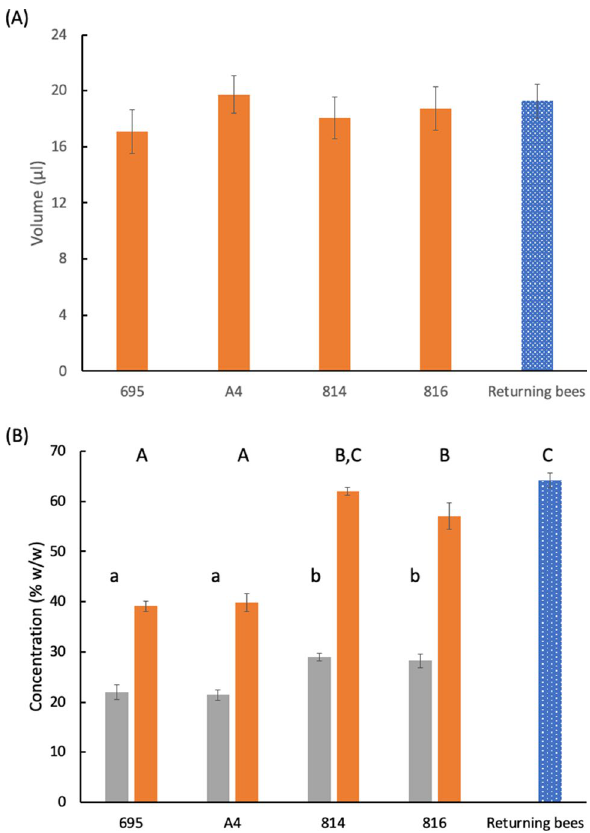
Figure 1. Crop contents of honey bees foraging on four cultivars of Macadamia integrifolia and captured on return to the hive. Nectar concentrations of the four cultivars are included. Values are means ± 95% CI (n = 30). ( A ) Volume in µl. ( B ) Concentration in % w/w of crop contents (orange) and nectar of the same cultivar (grey). Different letters indicate significant differences in crop contents; small letters refer to differences in nectar concentrations. Significant differences were determined by overlapping CIs between two